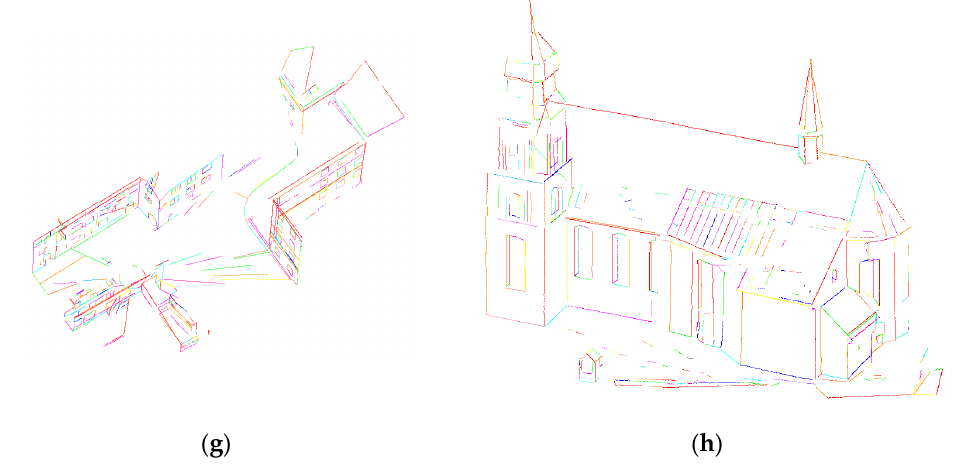
Figure 16. Effects of two outdoor scenes on plane segmentation, contour point extraction and 3D line segment extraction. The first column corresponds to Birdfountain and the second column corresponds to Bildstein. ( a , b ) are the input outdoor scenes. ( c , d ) are the plane segmentation results. ( e , f ) are the extracted contour points. ( g , h ) are the extracted 3D line segments. Table 4. Computational results for two outdoor scenes.